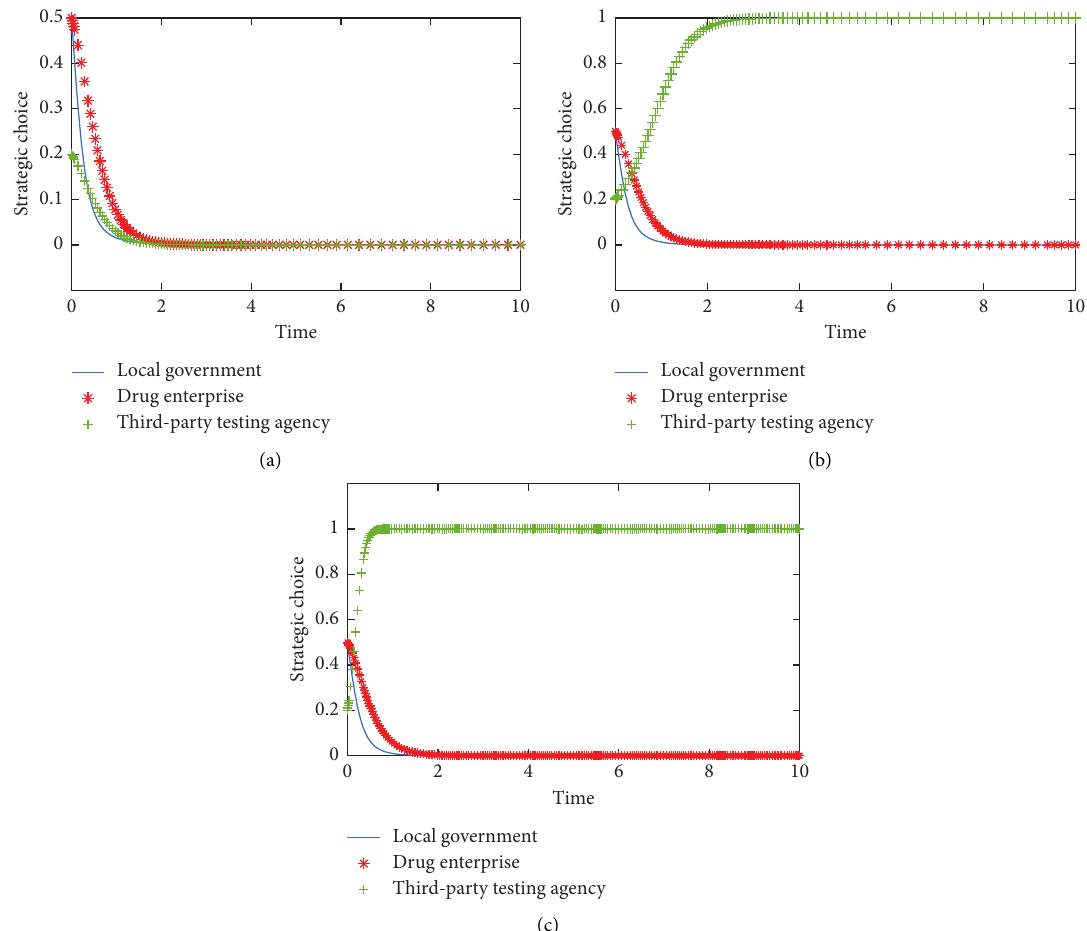
Figure 5: Impact of rewards on the evolution of each player’s strategy.